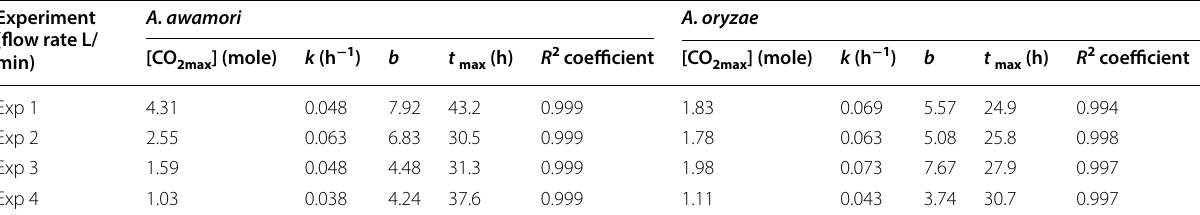
Table 3 Kinetics constants for carbon dioxide evolved by A. awamori and A. oryzae with different initial moisture content arrangements in multi-stacked tray Experiment (flow rate